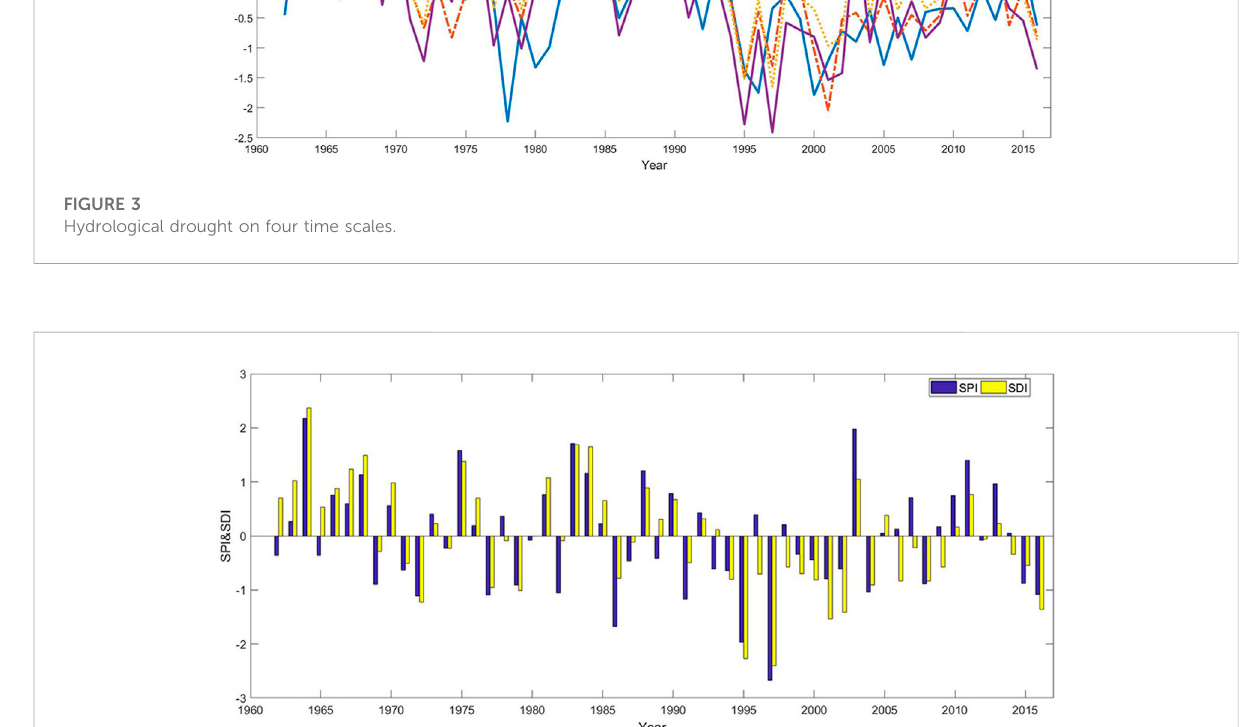
FIGURE 4 Meteorological drought and hydrological drought severity during 1961 – 2016 on a 12-month time